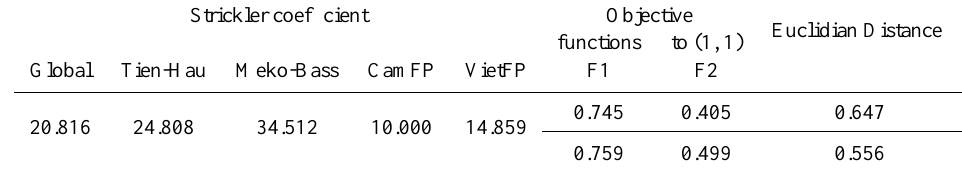
Table 6. Best Euclidian distance parameter set of the final Pareto optimal population and performance values of F1 and F2 and corresponding Euclidian distances to the optimal pit (1,1) with original (in normal font style, upper) and lowered dike heights (in bold, lower)